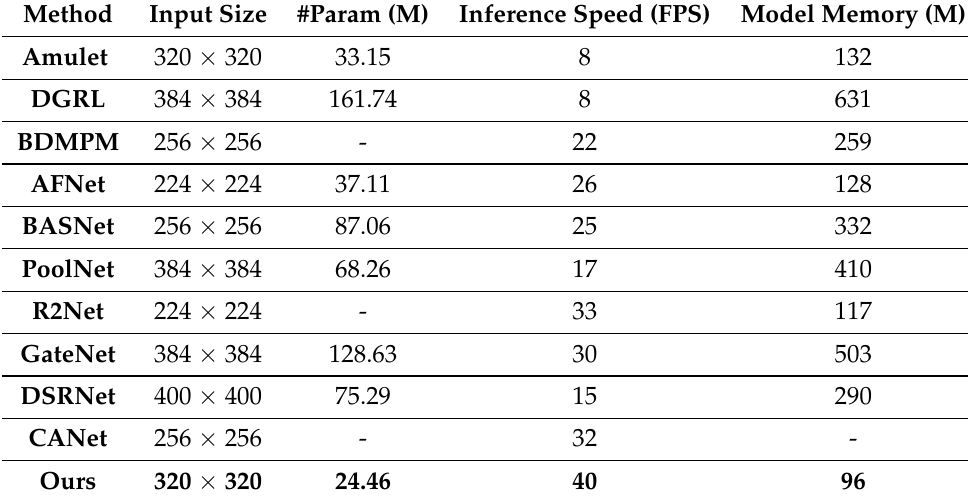
Table 2. The proposed GSCINet method and other SOD methods in the comparison of